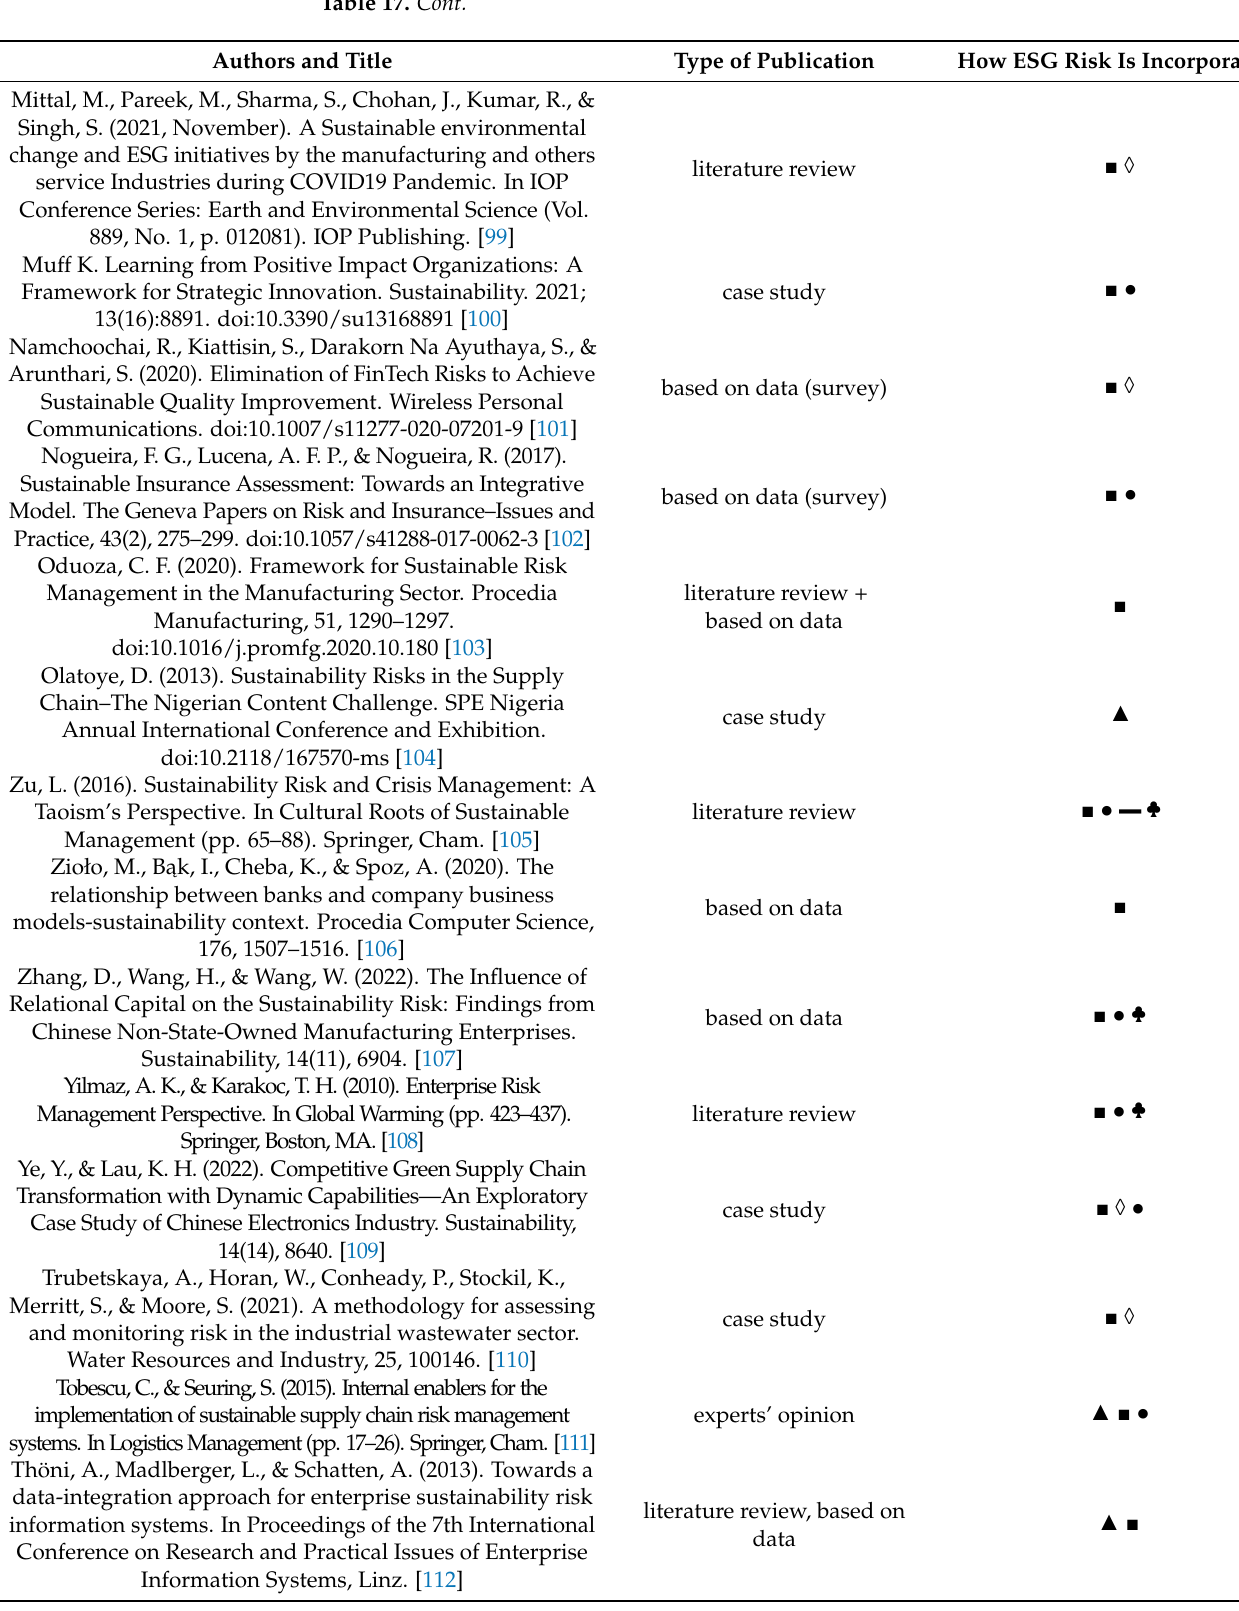
Table 17. List of publications with methods of incorporating ESG risk into business models Authors and Title